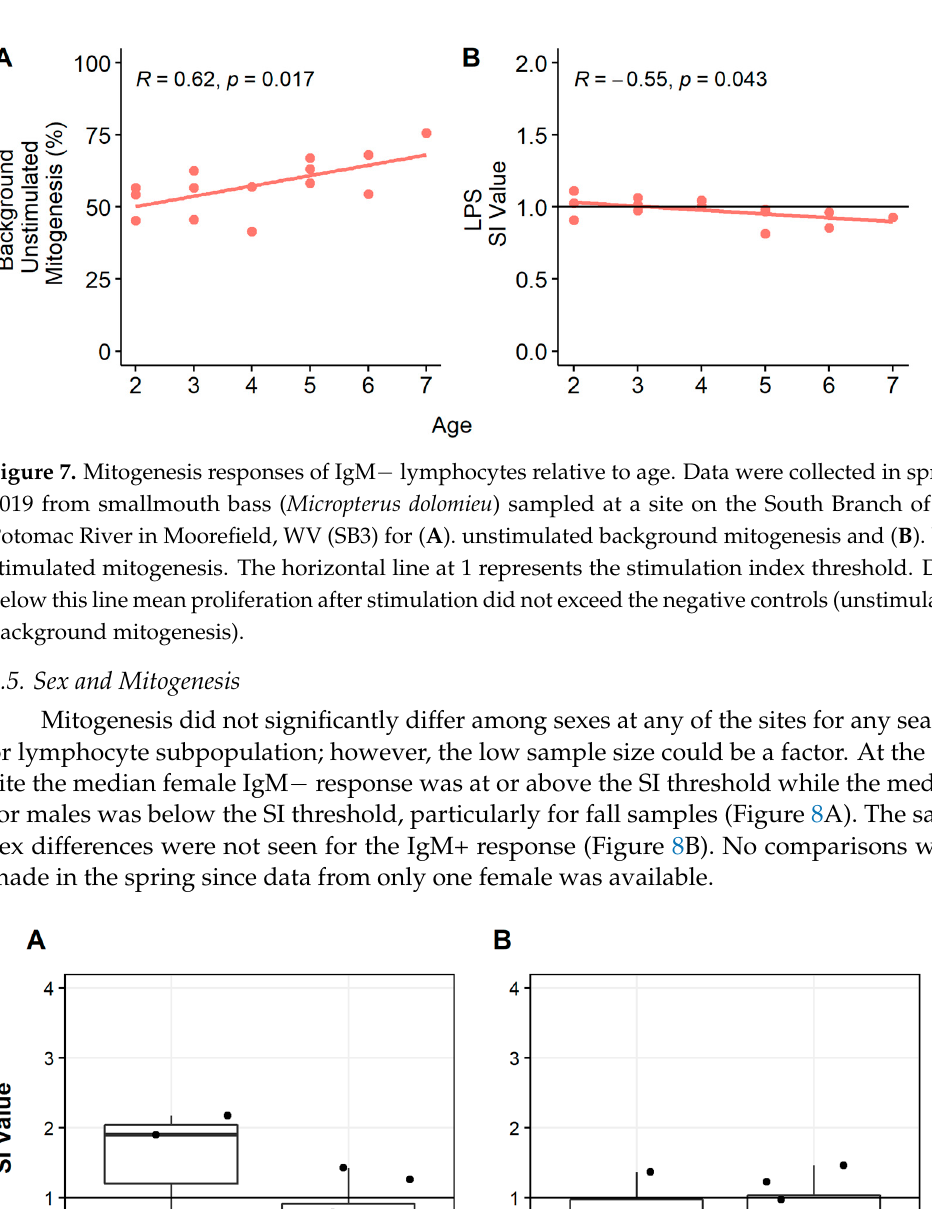
Table 3. Correlations between tissue parasites in spleen and lymphocyte mitogenesis for the Cheat River (CH) and South Branch Moorefield (SB3) sites. No significant correlations were observed at the South Branch Petersburg (SB1) site. Treatment